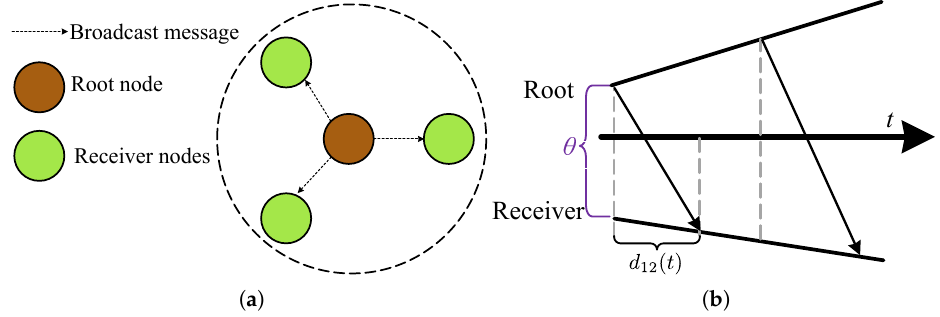
Figure 16. One-way messaging scheme, where a root node emits a synchronization message, and all of its neighbors receive. Each receiver synchronizes to the time of the root node. In ( a ), a typical operation of the scheme, and in ( b ), timeline of message